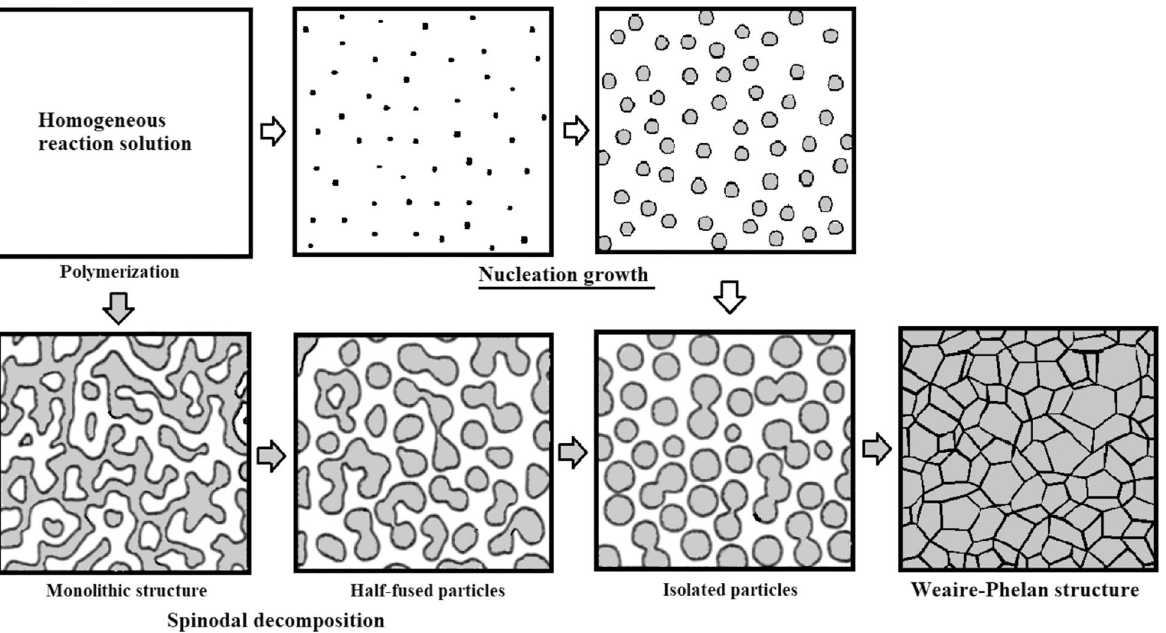
Figure 5. Phase separation models via nucleation growth and Spinodal decomposition to form Weaire-Phelan